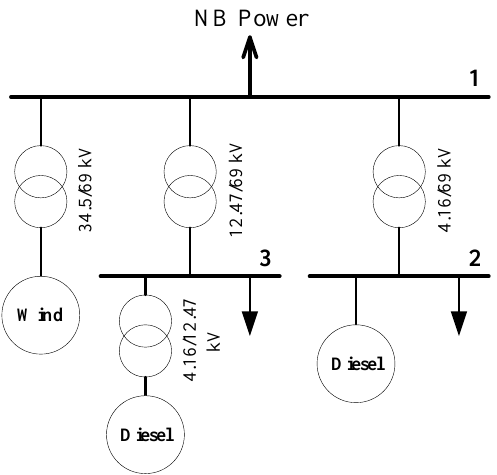
Figure 1. Single-line diagram of Summerside Electric grid.